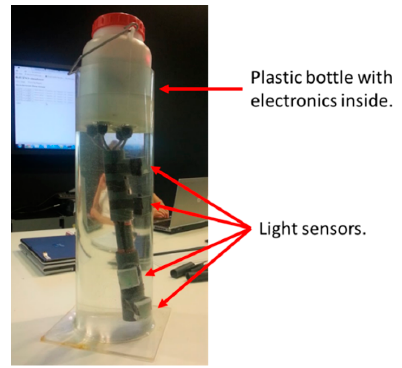
Figure 4. Presentation of the KdUINO.